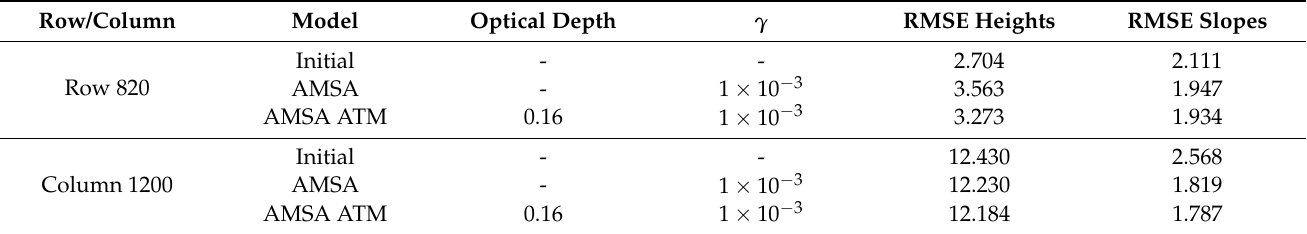
Figure 9. Resulting absolute heights compared for the two profiles investigated for image G20_025970_2217_XN_41N102W. Table 5. Comparison of the Root Mean Square Errors (RMSEs) for the examined lines in the DEMs based on image G20_025970_2217_XN_41N102W. The HiRISE DEM is the reference DEM to which the other DEMs are compared to. The initial DEM is the CTX stereo DEM, which is refined with the AMSA or AMSA ATM